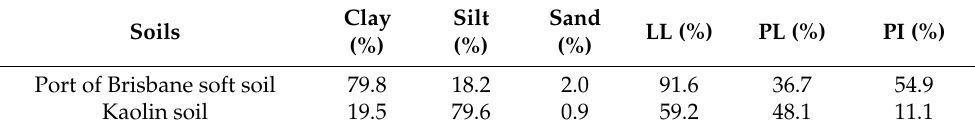
Table 1. Basic properties of the soils. Soils